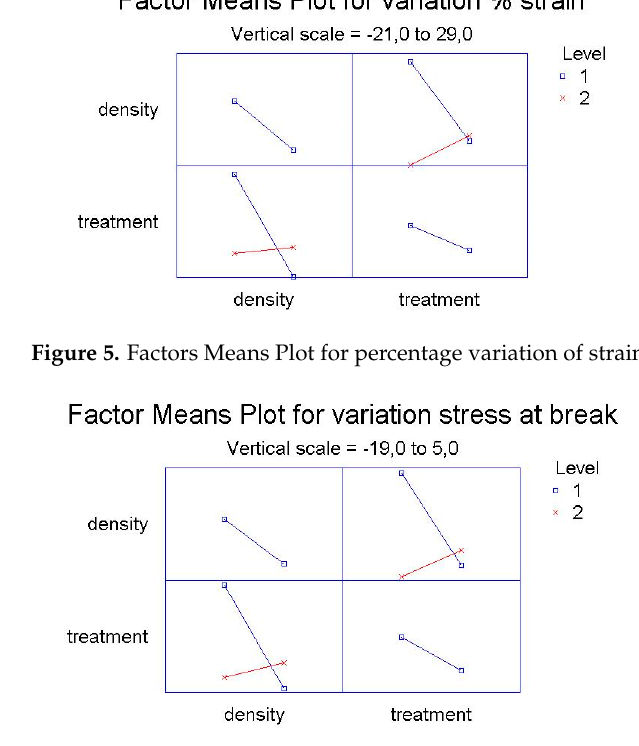
Figure 6. Factors Means Plot for variation of stress at break.